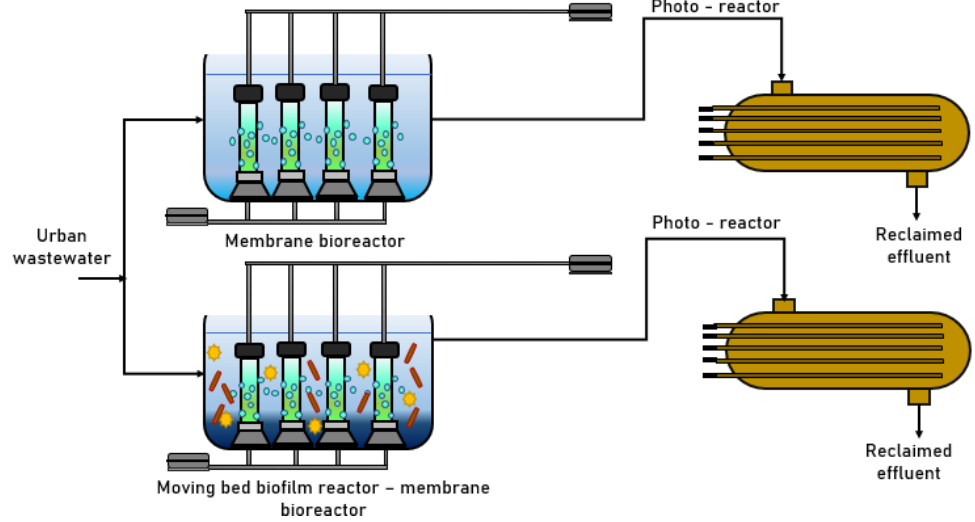
Figure 3. General scheme of the mixed-flow bioreactor.